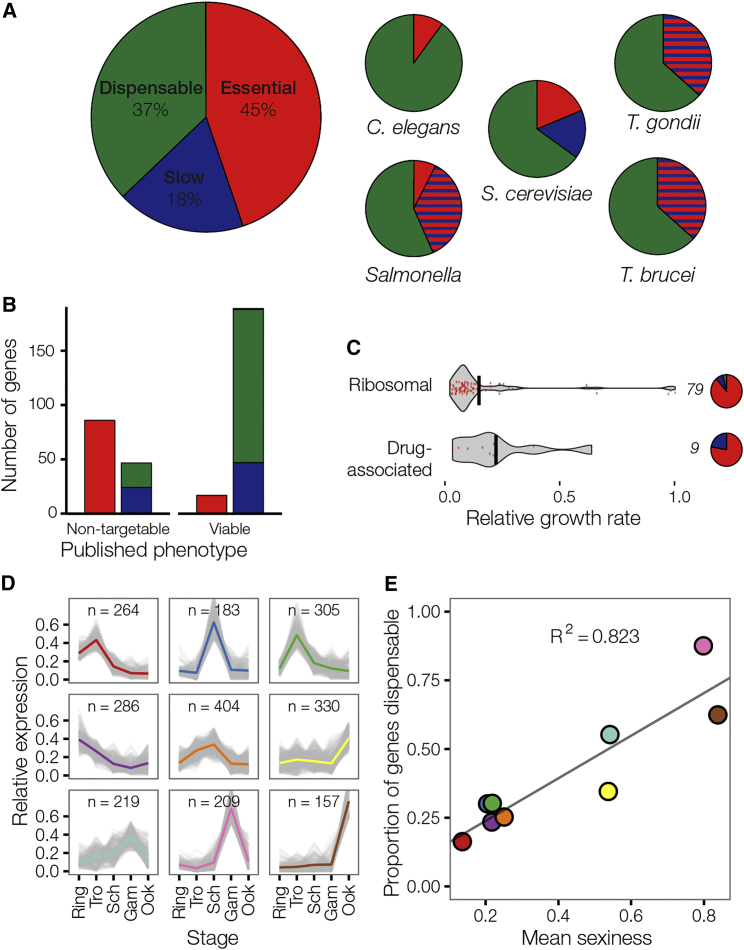
Most P. berghei Genes Are Required for Normal Growth of Asexual Blood Stages In Vivo(A) Frequency distribution of phenotypes in P. berghei compared to published data from other eukaryotes. Data from yeast are for growth in rich medium. Data from T. gondii are from a CRISPR-Cas9 screen in human foreskin fibroblasts. Genes required for normal growth are hatched red/blue since lethality and reduced growth phenotypes were not distinguished. Salmonella Typhimurium genes are for normal growth in medium (red) or additionally required for oral colonization of farm animals (hatched). T. brucei data is from an RNAi in vitro screen. See text for data sources.(B) BarSeq phenotypes compared to published data from RMgmDB.(C) Average RGR and phenotype distribution for predicted essential genes. Gene numbers per category shown next to pie charts. Enrichment for essential genes is significant at p < 0.001 for ribosomal genes and p < 0.1 for known drug targets.(D) All expressed genes covered by the screen were grouped into nine clusters depending on their relative expression across five life-cycle stages. All genes within a cluster were weighted equally.(E) For each cluster, the proportion of normalized read counts from sexual (gametocyte and ookinete) versus asexual developmental stages was calculated (“sexiness”) and plotted against the proportion of dispensable genes in that cluster. Ring, ring stage parasites; Tro, trophozoites; Sch, schizonts; Gam, gametocytes; Ook, ookinetes.See also Figures S2 and S3 and Tables S3 and S4.